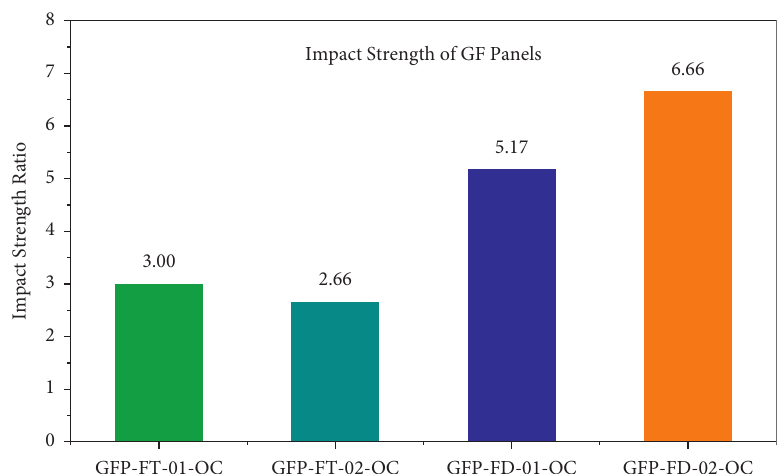
Figure 15: Residual impact strength of flat and folded GF panels.